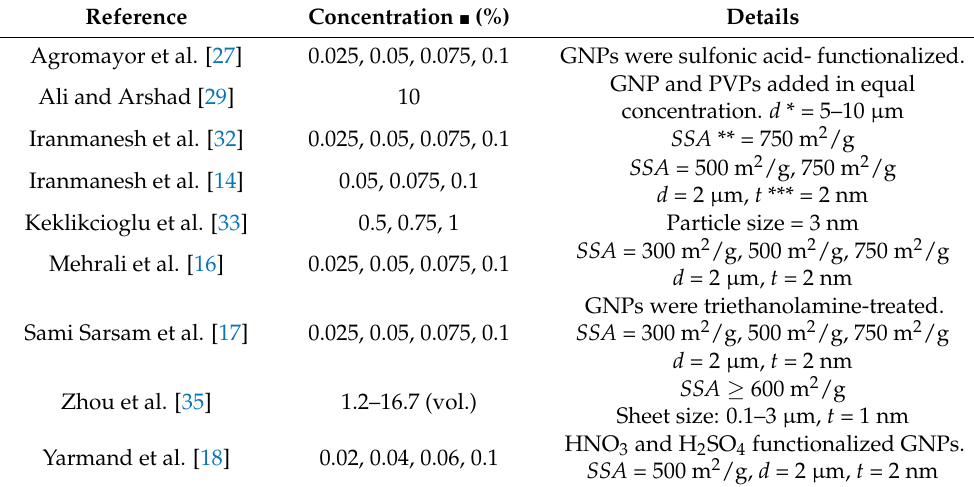
Table 1. Parameter summary of the previous works on the GNP-water nanofluids.